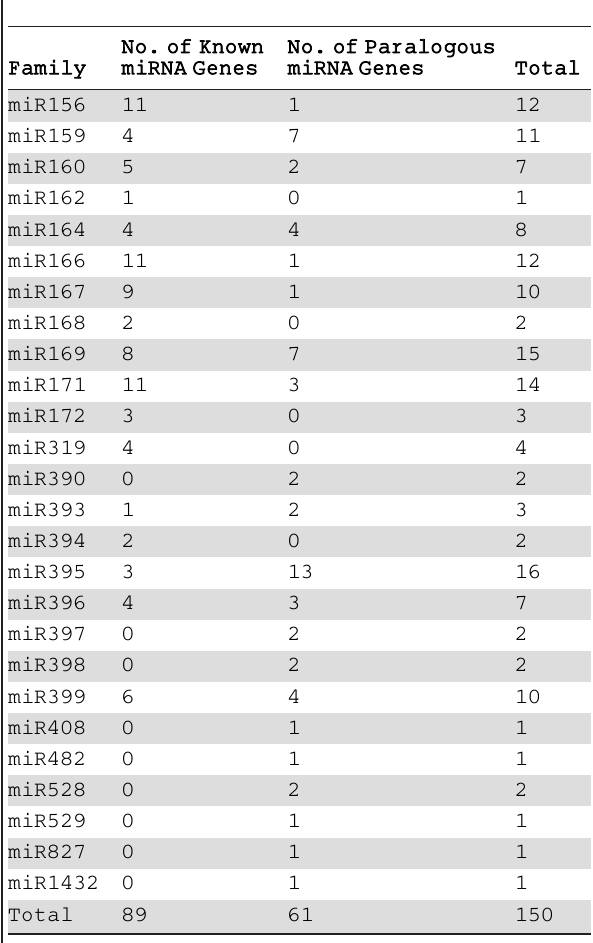
Table 1. Maize miRNA gene